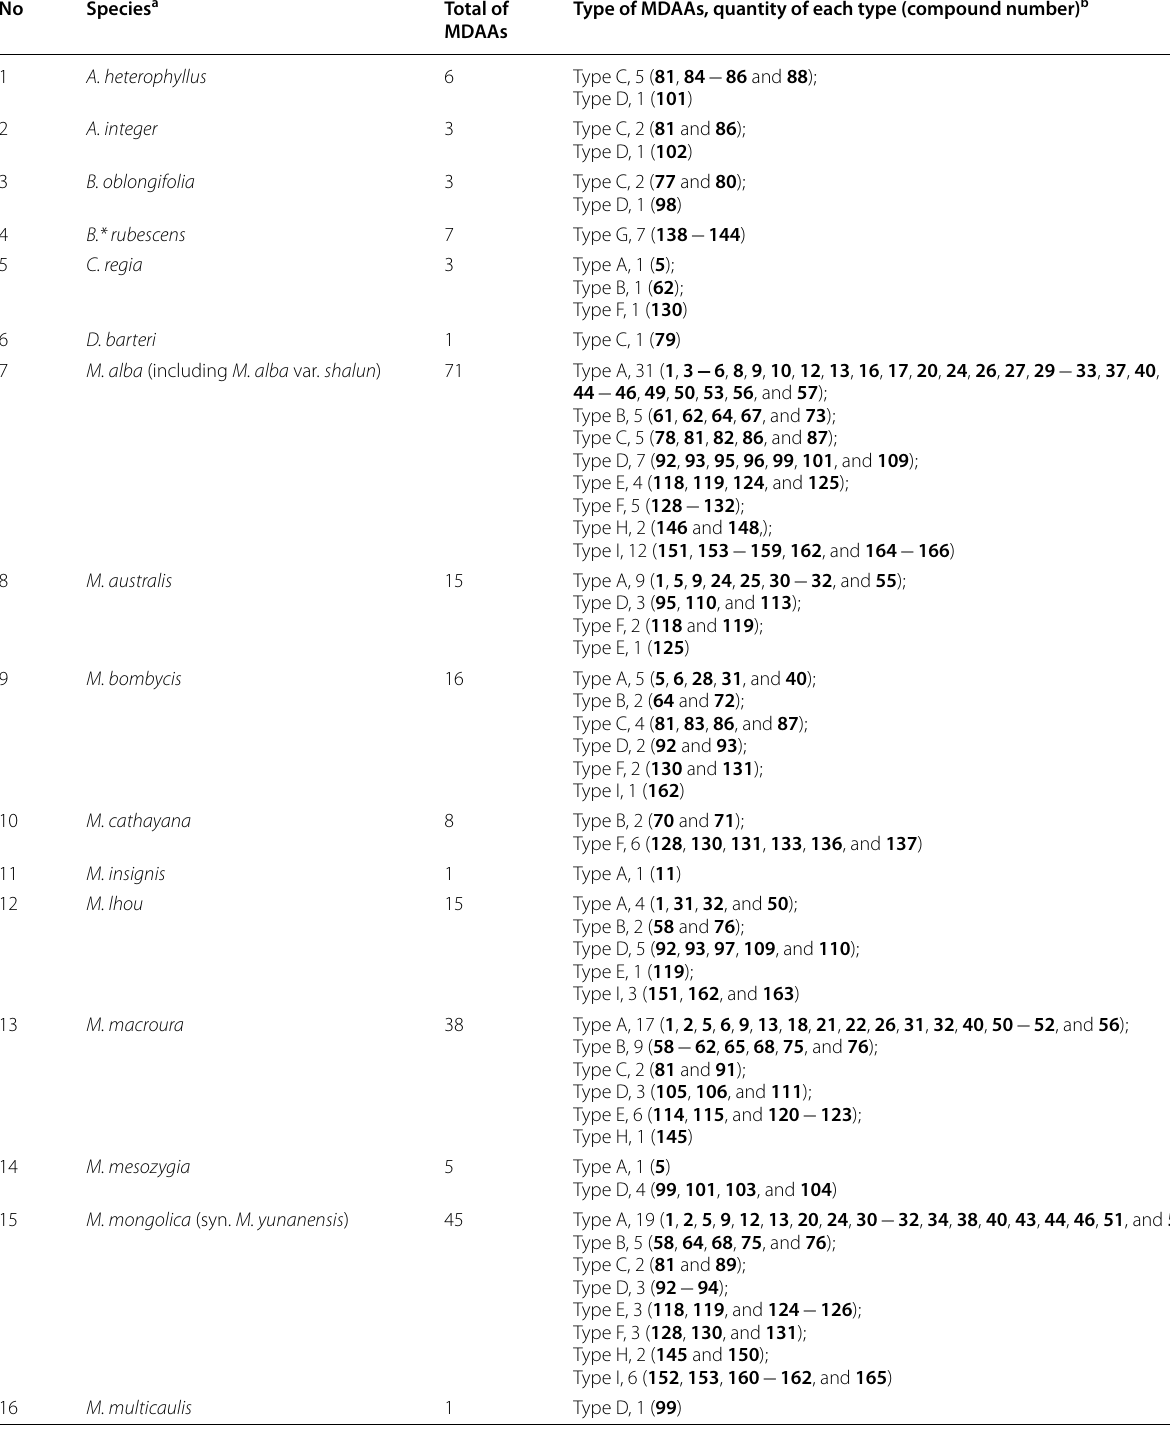
Table 2 Types and quantities of MDAAs distributed in different plant sources No Species